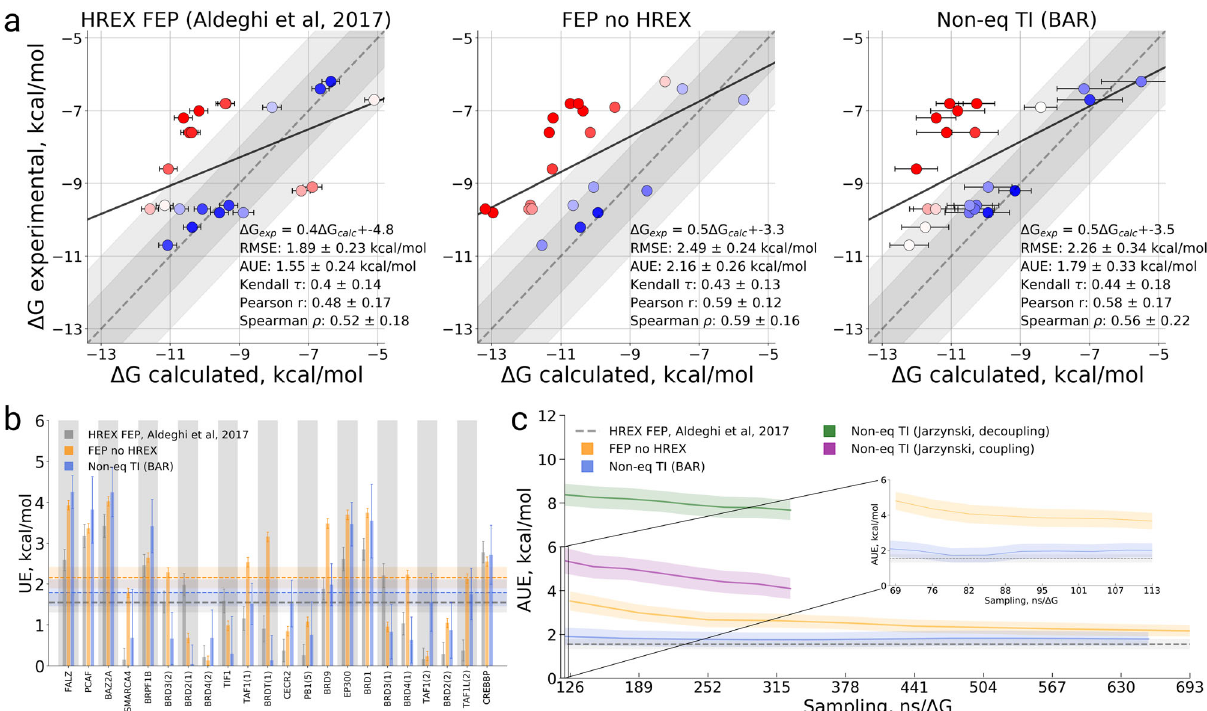
Fig. 5 Binding free energy calculation summary for the bromosporine selectivity against 22 bromodomains. a Calculated vs experimental Δ G values for the HREX FEP 12 , FEP without sampling enhancement and non-equilibrium TI approach. In the panels, we also provide a linear regression fi t as well as RMSE, AUE, Kendall, Pearson, and Spearman correlations. b Unsigned error (UE) by bromodomain for each of the considered protocols. c Average unsigned error (AUE) with respect to experimental measurement for varying sampling time invested for each of the investigated approaches. The time re fl ects only the sampling invested in the protein – ligand coupling part of the calculation. The dashed line for the HREX FEP value 12 marks only the accuracy of the estimate using the whole available sampling, i.e., it does not depict dependence on the sampling time. The inset shows the behavior of AUE for FEP and bi-directional non-equilibrium TI when less than 10% of the sampling production time is considered for the Δ G estimation. The uncertainties denote standard errors obtained by